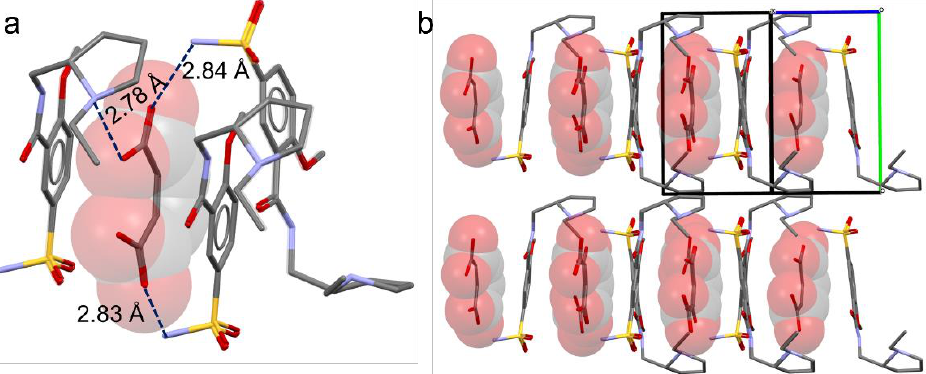
Figure 4. ( a ) Intermolecular interactions established between maleate moiety and surrounding hydrogenated SULP molecules (dashed blue lines). ESDs are omitted for the sake of clarity. ( b ) Crystal packing of SULP-MLEA along (101) direction. Color code C = grey, N = blue, O = red, S = yellow. MLEA ions are highlighted with spacefill style shadow. Hydrogen atoms are omitted for the sake of